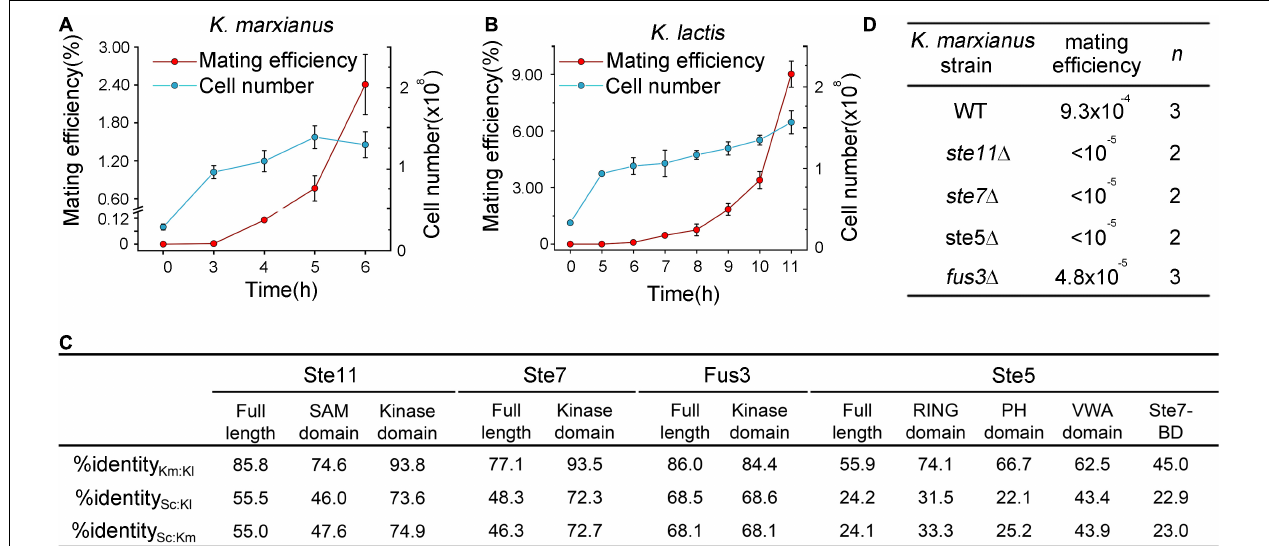
FIGURE 2 | Mating in K. marxianus and K. lactis . (A,B) Time course of mating in K. marxianus (A) and K. lactis (B) . Wild-type K. marxianus strain LHP508 was mated with tester strain LHP560. Wild-type K. lactis strain LHP570 was mated with tester strain LHP571. The quantitative mating assay was performed as described in section “Materials and Methods.” At indicated times, cells were washed from the filters and placed on the mating medium. The total cell number was counted by colonies formed on YPD plates. Mating efficiencies were calculated as described in Methods. The value represented mean ± SD from three biological repeats. (C) Identity among orthologs and domains of Ste5 and associated kinases in S. cerevisiae , K. marxianus and K. lactis . Sequences of full-length proteins and domains were obtained as shown in Methods and then aligned. Km was short for K. marxianus , Kl for K. lactis , Sc for S. cerevisiae and BD for binding-domain. (D) Mating efficiency of ste5 (cid:49) , ste11 (cid:49) , ste7 (cid:49) and fus3 (cid:49) mutants in K. marxianus . LHP562 ∼ LHP564 was subjected to the quantitative mating assay. The mating efficiency was calculated as the ratio of diploid cells to total cells. “ n ” represents the number of biological repeats.